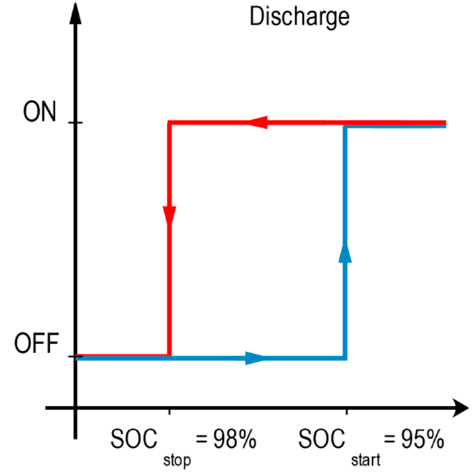
Figure 6. Hysteresis loop to start the SoC recovery process.